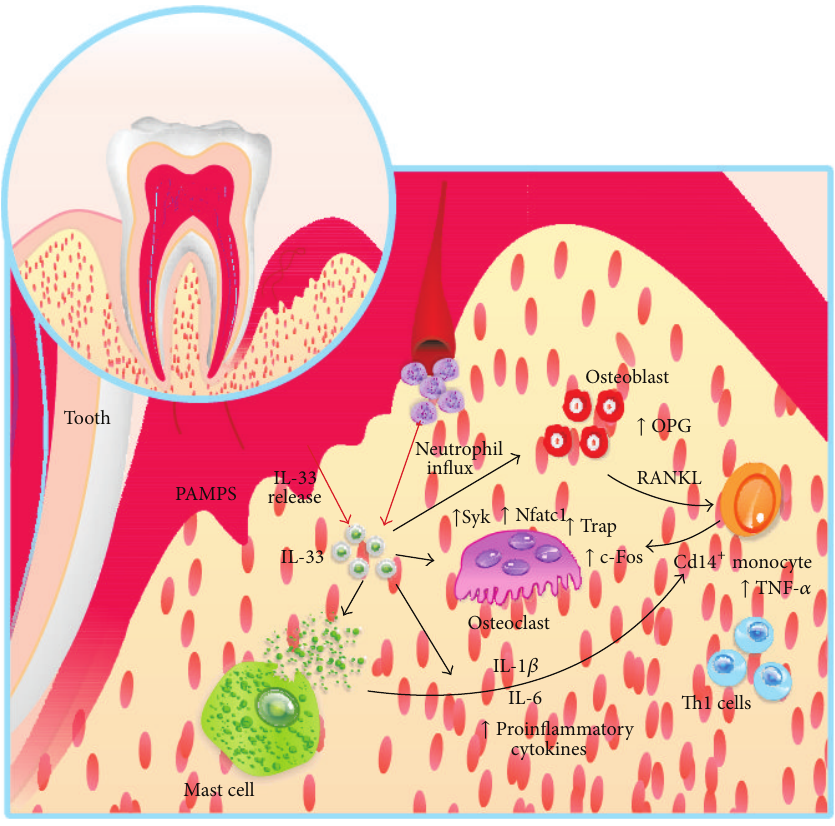
Figure 2: Possible role of IL-33 in periodontal disease. The destruction (necrosis) of the epithelial cells and gum releases IL-33 and acts as a chemoattractant and cytokine. The influx of mast cells, Th1 cells, and monocytes to the inflammation site, in the presence of IL-33, activates mast cell degranulation and production of proinflammatory cytokines, inducing osteoclastogenesis. Almost, IL-33 induces neutrophil influx, production of activator of nuclear factor kappa-B ligand (RANKL), and decrease of osteoprotegerin (OPG) production by osteoblast, favoring osteoclastogenesis by increasing osteoclastogenic factors as spleen tyrosine kinase (SYK), nuclear factor of activated T cells (Nfatc1), and tartrate-resistant acid phosphatase